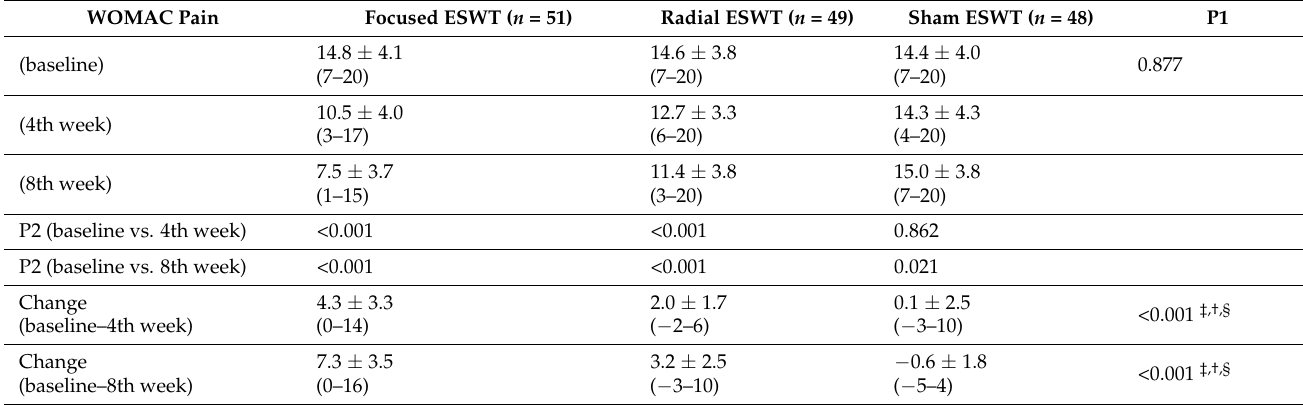
Table 3. Statistical analysis for the WOMAC pain